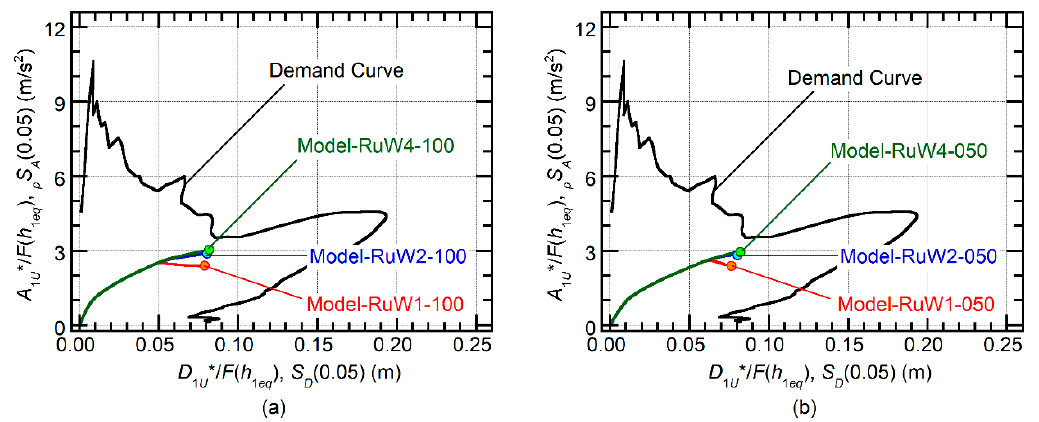
Figure 30. Comparison of the factored capacity curve and the demand curve of the first earthquake (14 April 2016): ( a ) Models RuW1-100, RuW2-100, and RuW4-100, and ( b ) Models RuW1-050, RuW2-050, and RuW4-050.